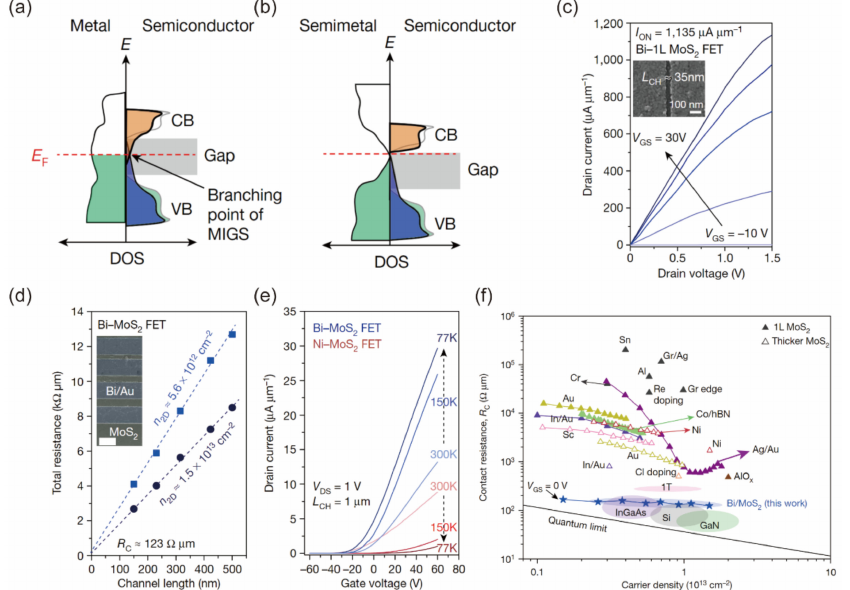
Figure 3. Band structure of normal metal contact ( a ) and bismuth–semiconductor contact ( b ). The Fermi level of the semi-metal aligns with the conduction band of the semiconductor, the density of states at the Fermi level of the semimetal is near-zero, and metal-induced gap states are suppressed. ( c ) Output curves of a 35-nm Bi − MoS 2 FET with a high current density. ( d ) Contact resistance of MoS 2 FETs with bismuth electrodes. ( e ) Transfer curves of Bi − MoS 2 and Ni − MoS 2 FETs at various temperatures. ( f ) State-of-the-art contact technology for MoS 2 transistors as a function of n 2d . Reprinted/adapted with permission from Ref. [7]. Copyright 2021, Springer